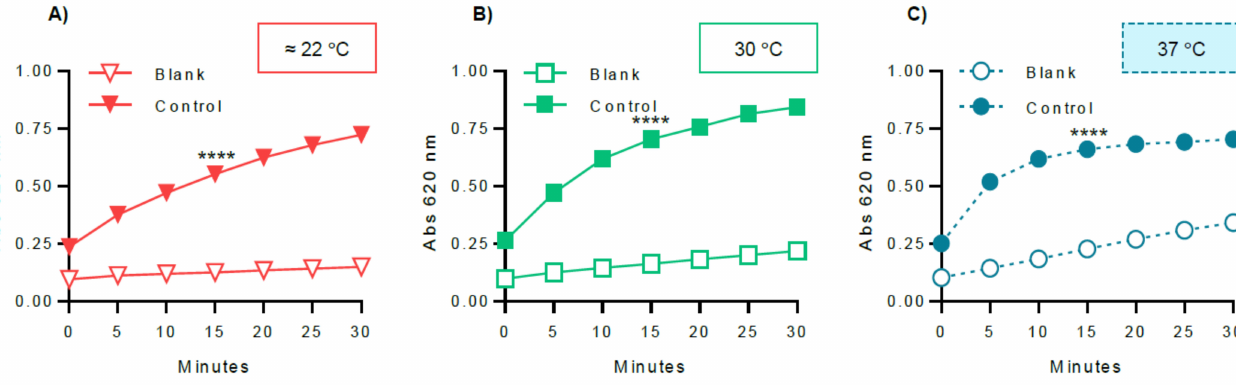
Figure 8. Optimization of the assay temperature: ( A ) ≈ 22 ◦ C, ( B ) 30 ◦ C, and ( C ) 37 ◦ C. GPa, glucose 1-phosphate, and glycogen were fixed at 0.38 U/mL, 0.25 mM, and 0.25 mg/mL, respectively. The blank contained the same constituents as the control, except the enzyme. The obtained results represent at least four independent experiments and were graphically represented as mean ± SEM. **** p < 0.0001 when compared with the blank (without enzyme) at 15 min of incubation. Once we defined the GPa (0.38 U/mL) and glucose 1-phosphate (0.25 mM) concen- trations, the next experimental parameter to be defined was glycogen, by varying the concentration at 0, 0.13, 0.25, 0.50, and 1.00 mg/mL, as represented in Figure 7.